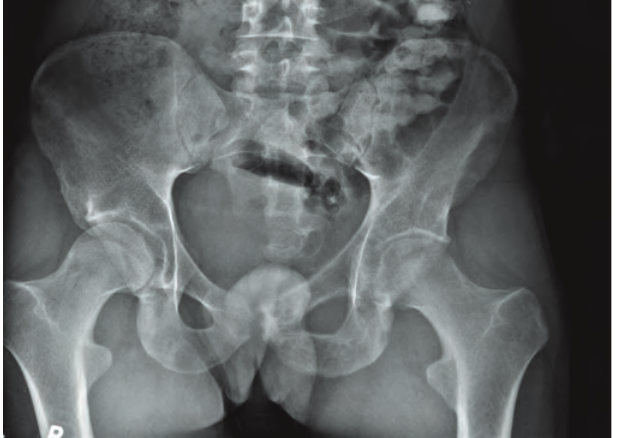
Fig. 5. AP plain film of the pelvis. Note the predominantly permeated lytic process that involves the body, superior and inferior rami of the left pubic bone with an associated diffuse interrupted laminated periosteal reaction.